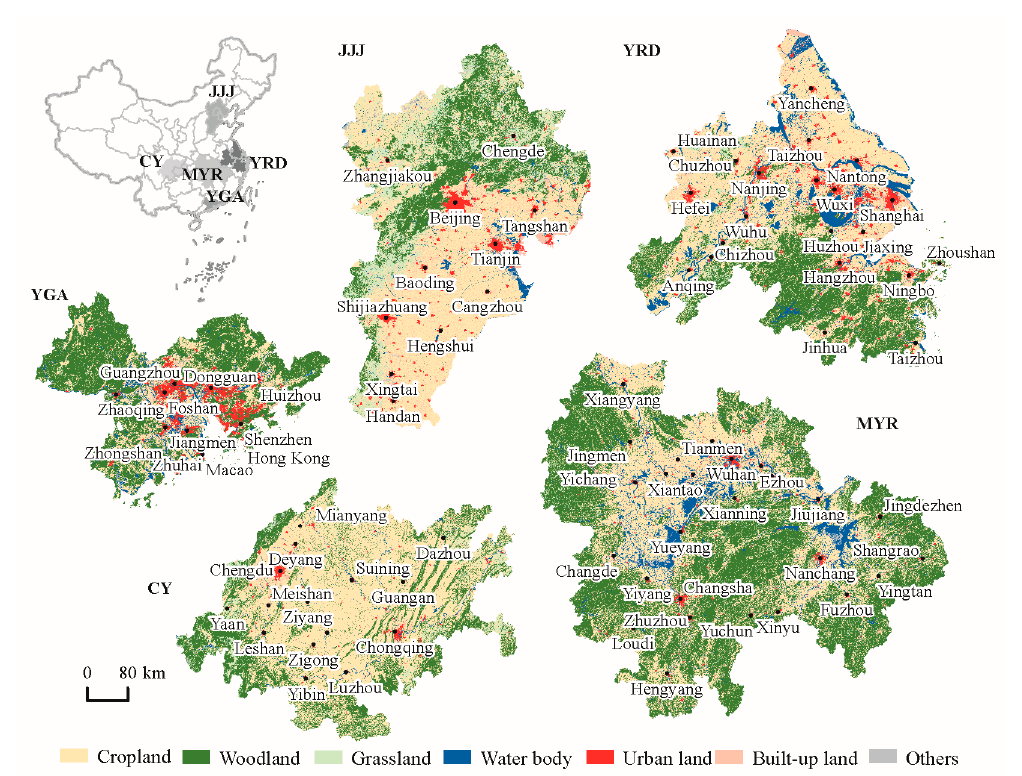
Figure 1. Study area and the location of the megaregions.